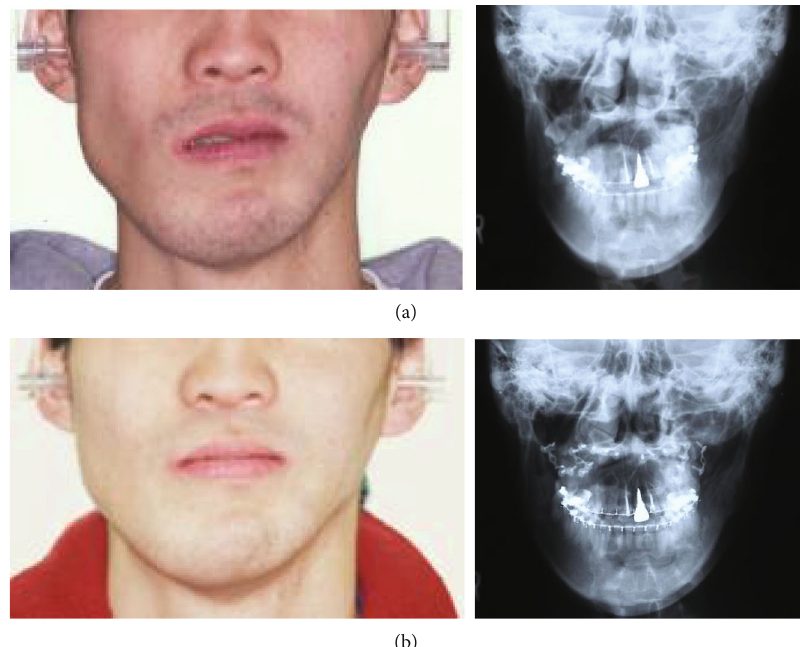
Figure 3: Facial photographs and frontal cephalograms before (a) and after two-jaw surgery (b).